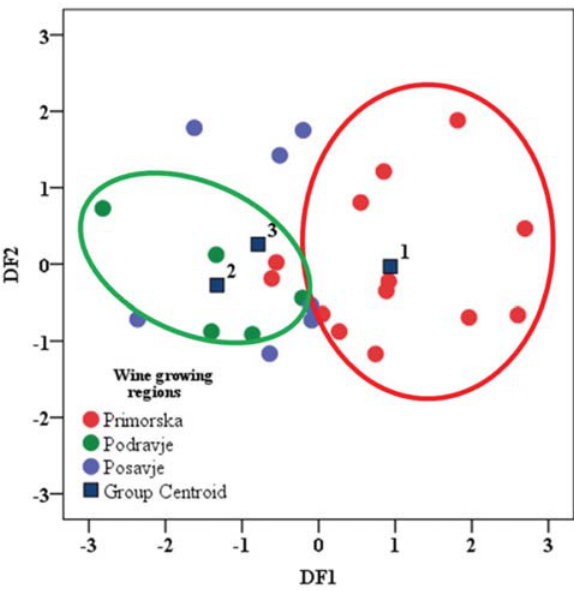
Figure 2. Graphic output of LDA in the plane of the first two dis- criminant functions. Classification according to Slovenian wine growing regions